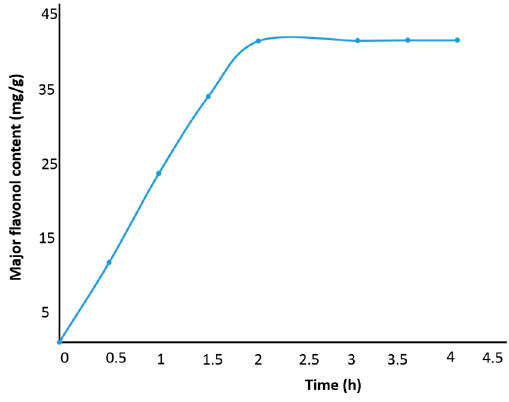
Figure 2. The effect of extraction time on the major flavonol yield.